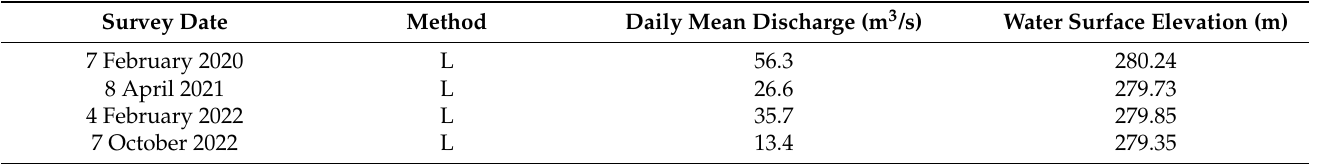
Table 5. Dates, daily mean discharges at the Limons gauging station (“https://hydro.eaufrance.fr (accessed on 15 February 2023)”), and water surface elevations at the bank for all survey campaigns at Site 2, which permitted us to calculate erosion rates of the restored bank. (L)